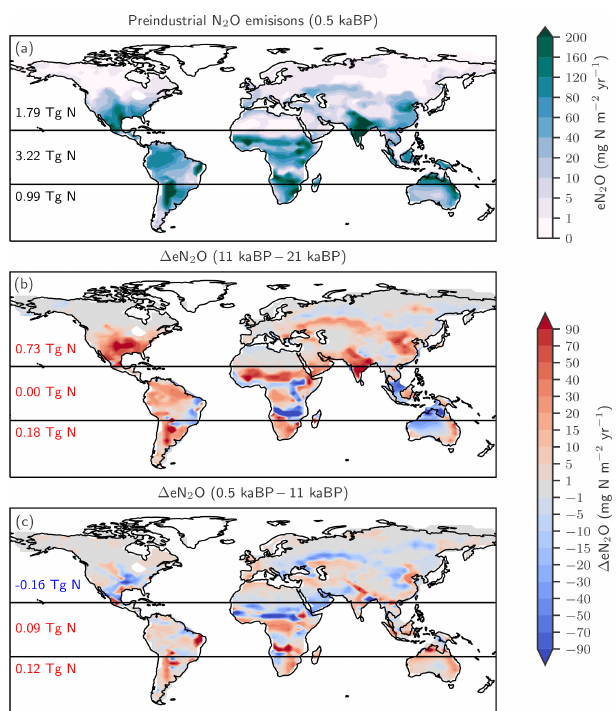
Figure 4. Preindustrial patterns (a) and changes in terrestrial N 2 O emissions for the last glacial termination ( b ; 11ka minus 21ka) and the Holocene ( c ; 0.5ka minus 11ka) as simulated with LPX- Bern(v1.4N). Numbers indicate integrated values for three latitudi- nal bands (90–20 ◦ S; 20 ◦ S–20 ◦ N; 20–90 ◦